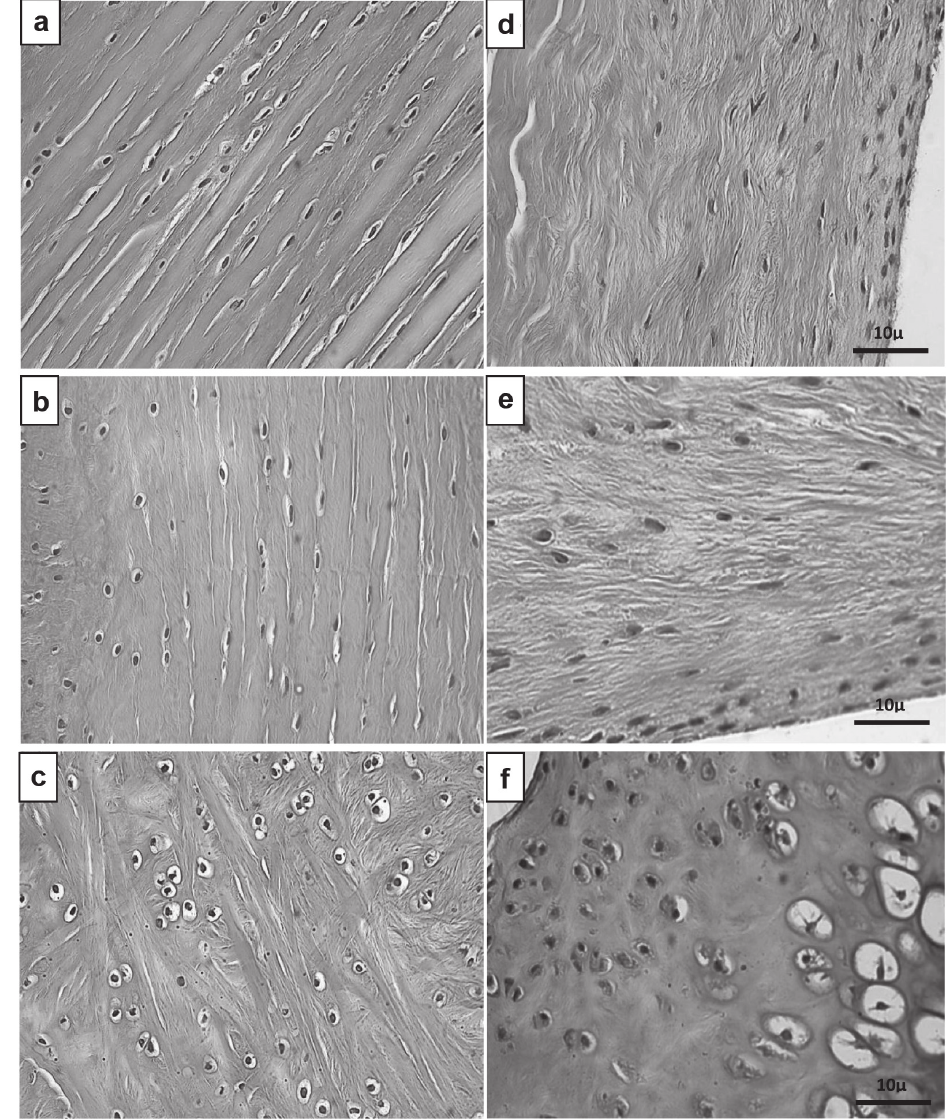
Figure 4 - Photomicrographs of the horns of the contralateral ( a and b ) and treated menisci ( d and e ), showing the presence of fibrocytes and fibroblasts in the peripheral and central regions. In c (contralateral) and f (treated) chondrocytes are scattered throughout the body of the meniscus. HE. (See the colors in the online